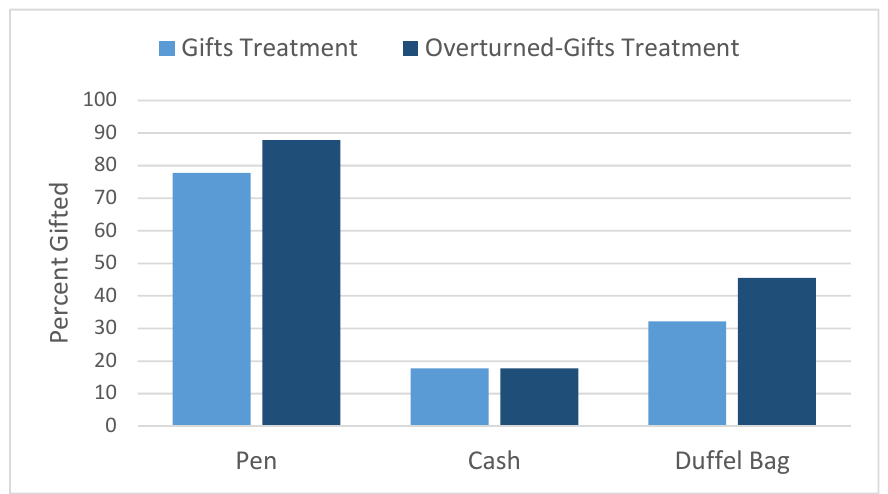
Figure 6. Gift‐giving behavior by item and treatment. All gift‐givers received exactly two chances to gift each item in both the gift and overturned gift treatments.